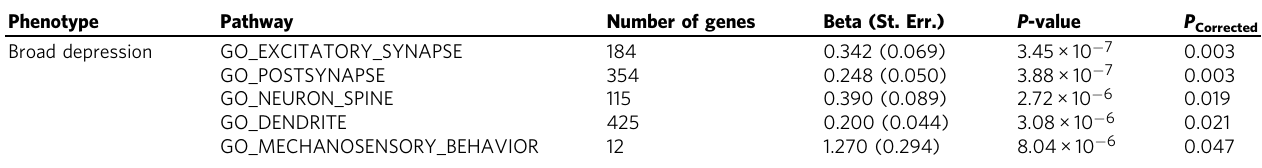
Table 2 Pathways with a signi fi cant effect ( P corrected < 0.05) on broad depression following multiple testing correction identi fi ed through gene-set enrichment analysis